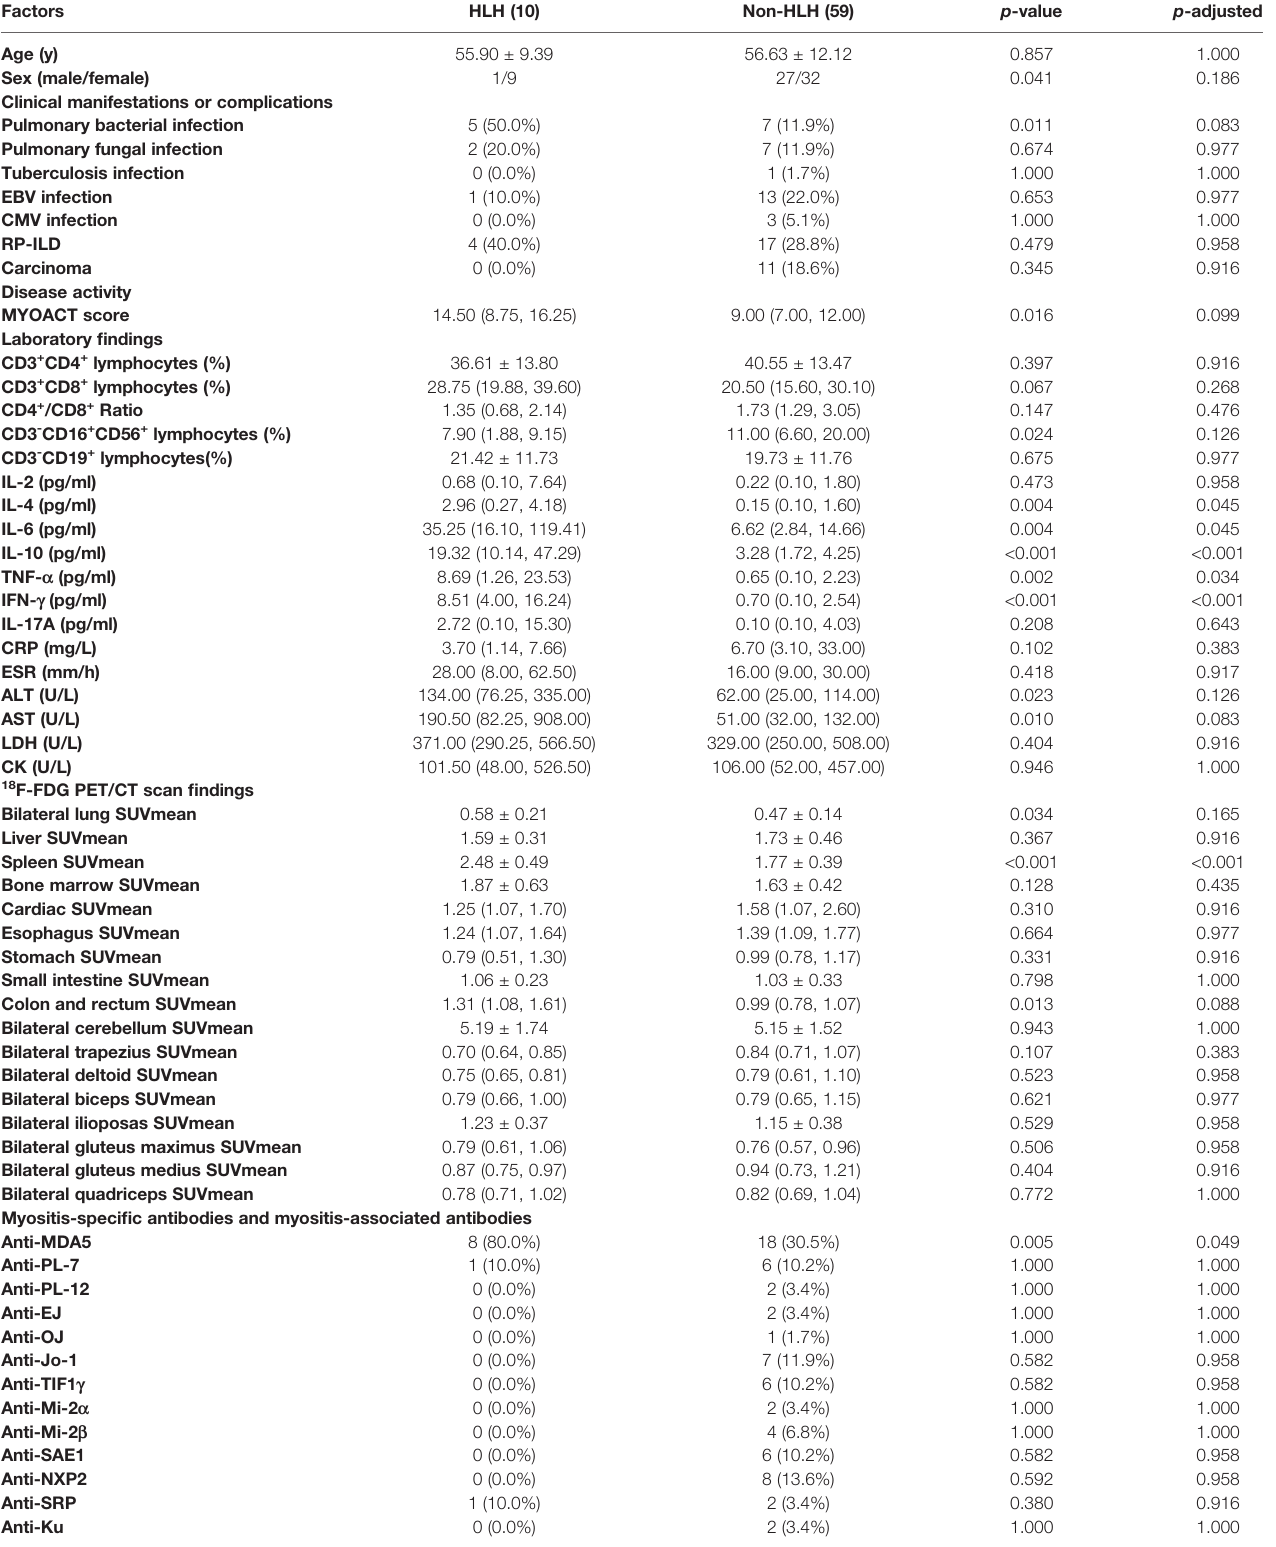
TABLE 1 | Comparisons of multiple factors between HLH and non-HLH groups. Factors